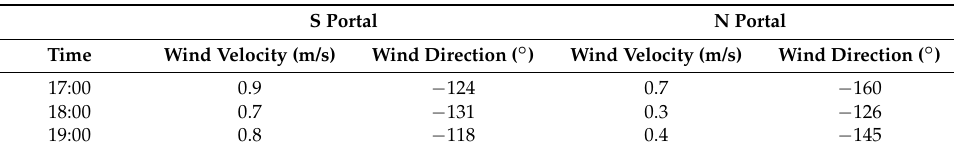
Table 2. The variations of wind velocity and wind direction during the